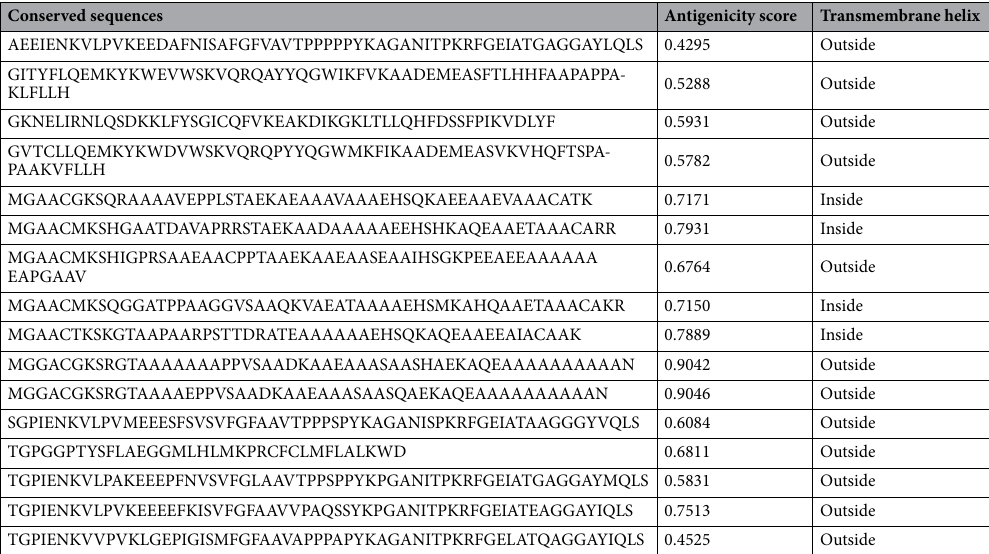
Table 1. Conserved sequences of the genome sequence of Eimeria .